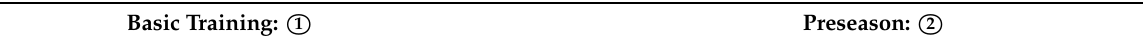
Table 1. Contents of usual sprint training for submaximal and maximal running in a large number of runs.